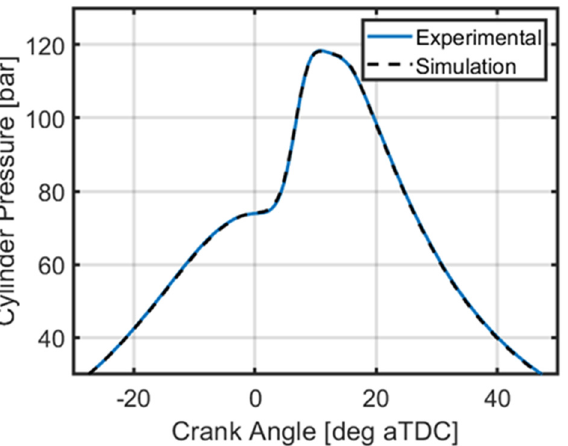
Figure 13. Cylinder pressure vs. crank angle of showing validation of 0-D thermodynamic engine cycle.